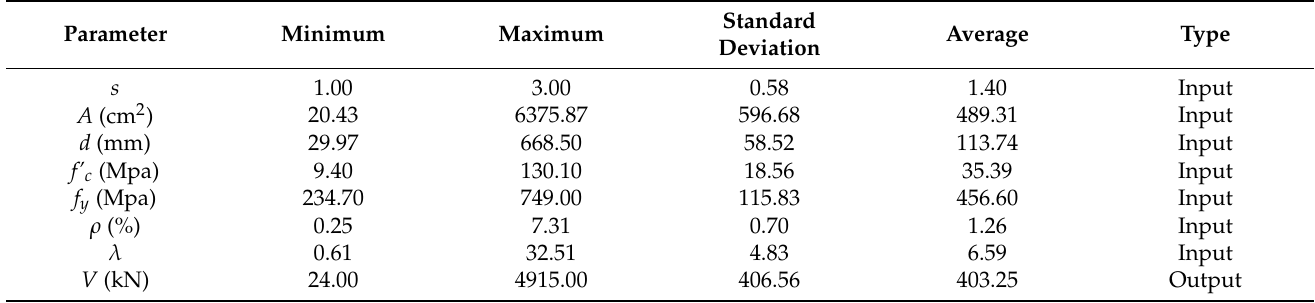
Table 1. Statistic information of input variables.